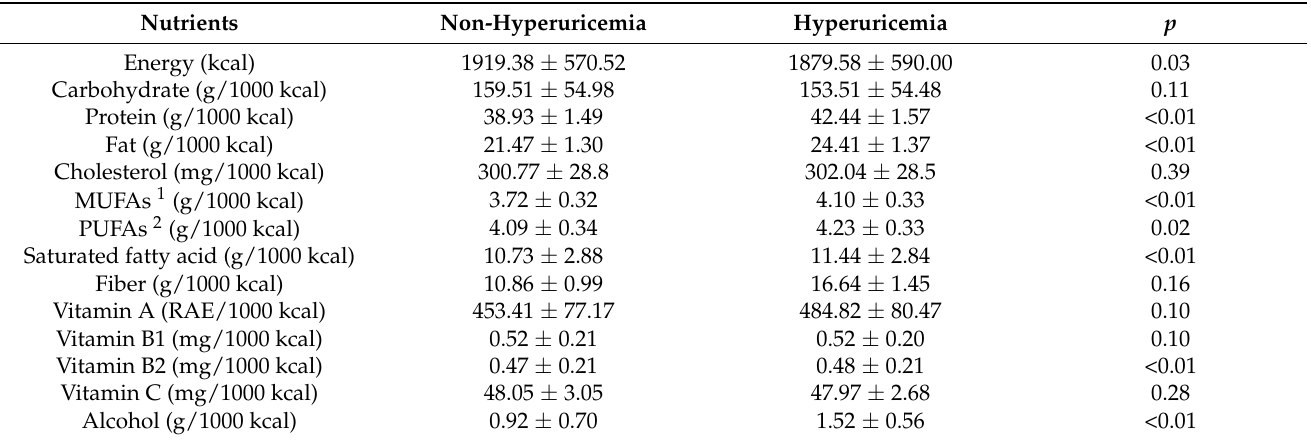
Table 2. Dietary intakes of energy and energy-adjusted dietary intakes (per 1000 kcal).